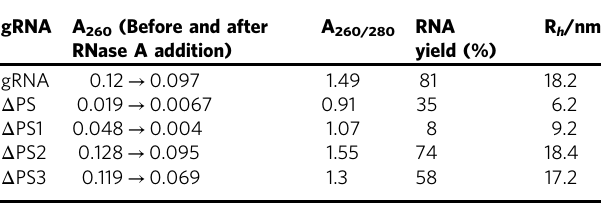
Table 1 Characterisation of NCPs reassembled around gRNA